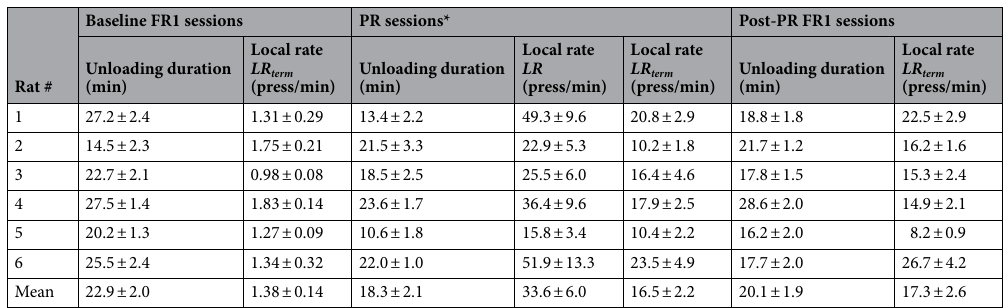
Table 2. Duration of unloading phases, LR term and LR of lever-pressing activity in individual rats. *—data collapsed across cocaine unit doses of 6 and 12 µmol/kg.